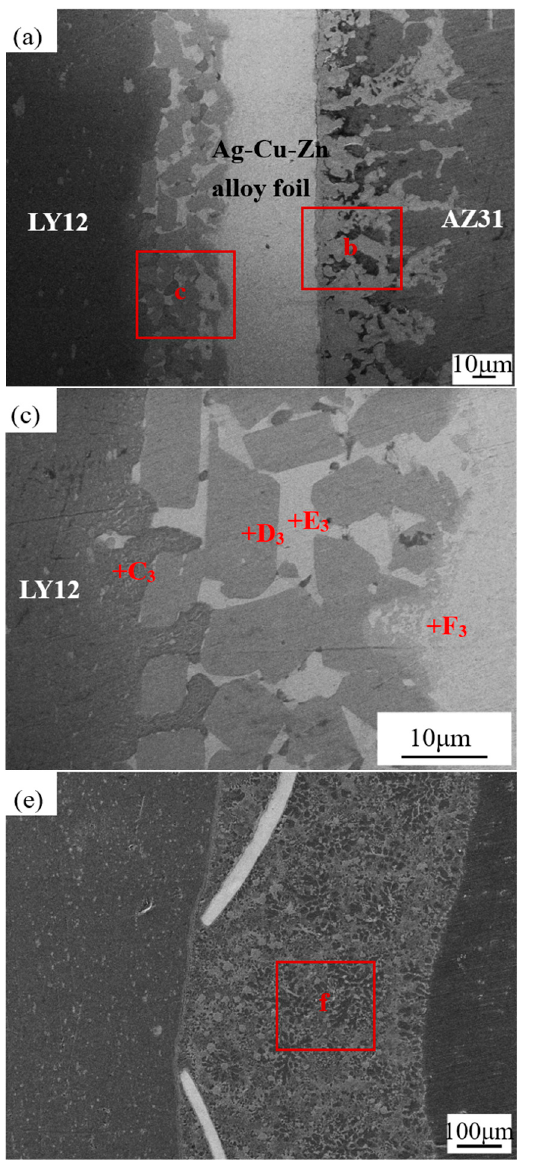
Figure 4. Microstructure evolution of the joints with increasing UST at 460 °C: ( a – c ) 5 s; ( d ) 10 s; and ( e , f ) 15 s. Panel ( b ) refers to area b in ( a ), panel ( c ) refers to area c in ( a ), and panel ( f ) refers to area f in ( e ). Table 3. Chemical composition of different regions shown in Figure 4 (at.%).